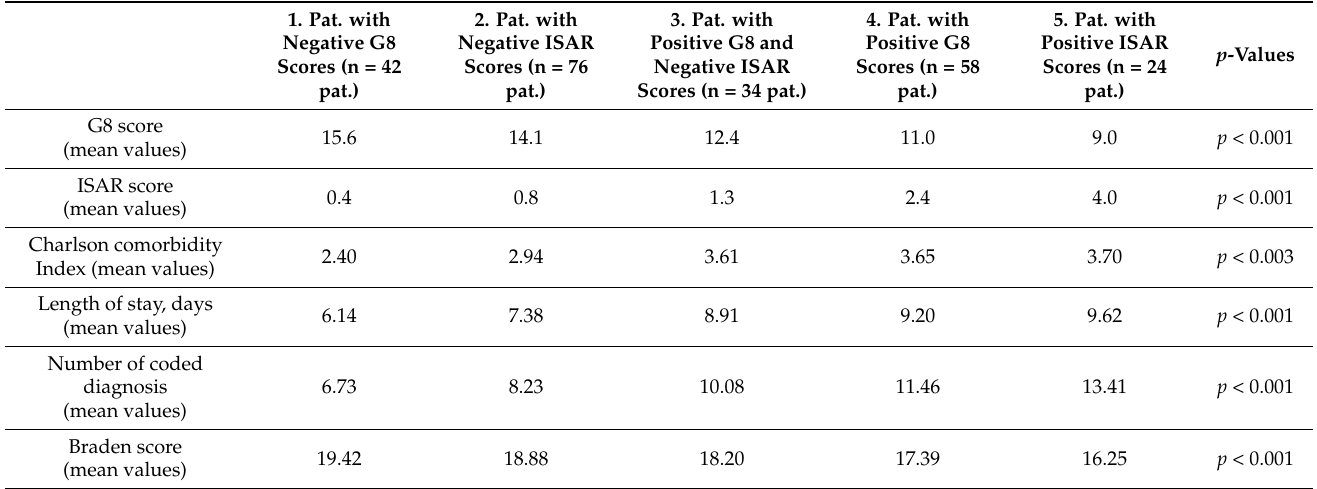
Table 3. Mean values of the G8 score, ISAR score, and clinical data of different patient groups. Groups were built according to the score results (positive/negative screening